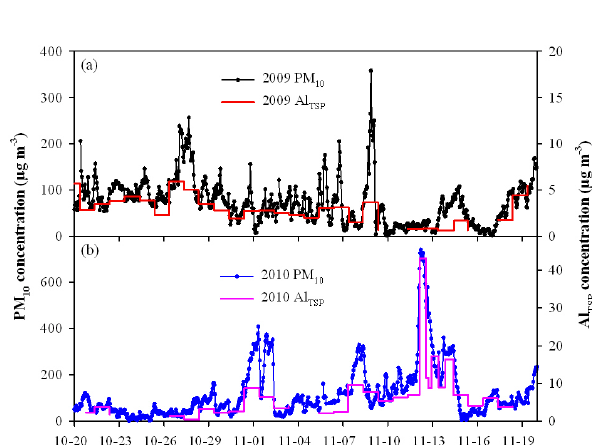
Fig. 8. Same as Fig. 4 but for the autumn of 2010 and 2009, respectively. Figure 8. Same as Figure 4 but for the autumn of 2010 and 2009, respectively.